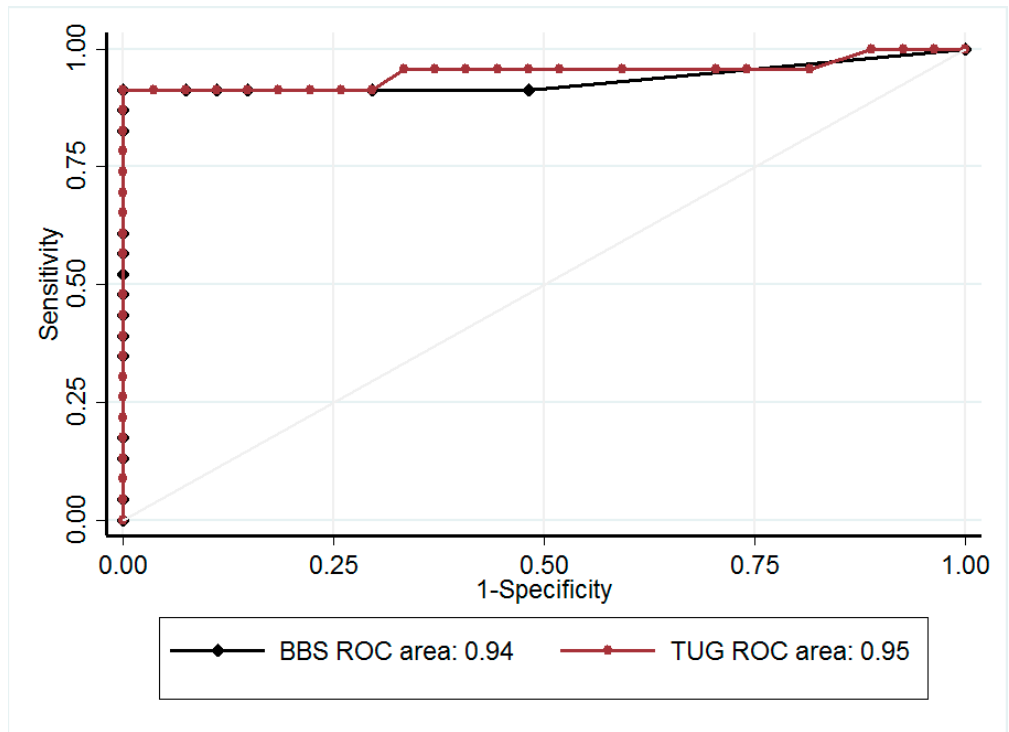
Figure 1. Receiver operating characteristic (ROC) curves for detecting fallers with the Berg Balance Scale score (BBS, black) and with the Timed Up and Go test (TUG, red). Area under curves (AUC) is indicated at the bottom of the paragraph.